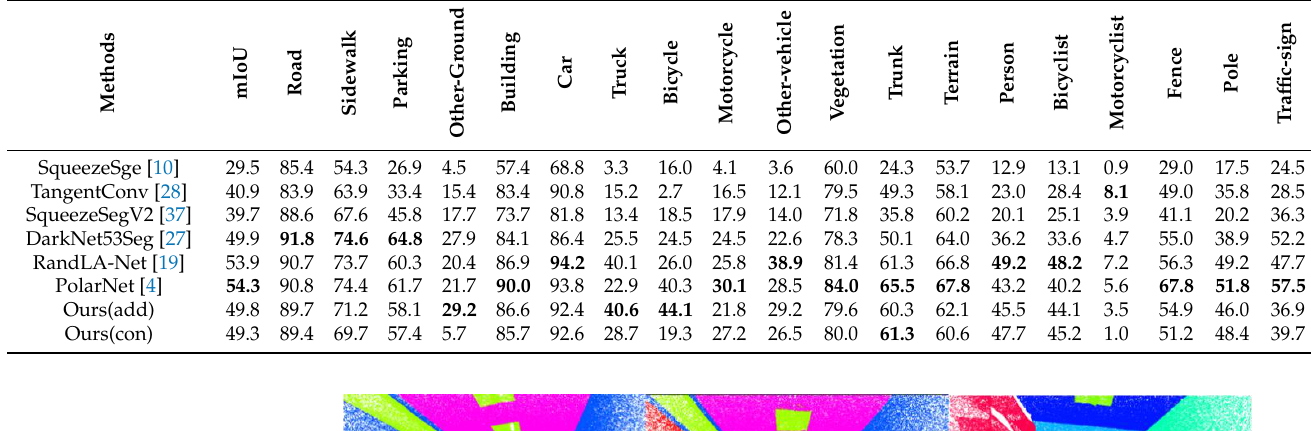
Table 4. Quantitative results on the SemanticKITTI dataset (add: the two attention weight matrices added; con: the two attention weight matrices fused at the feature level).